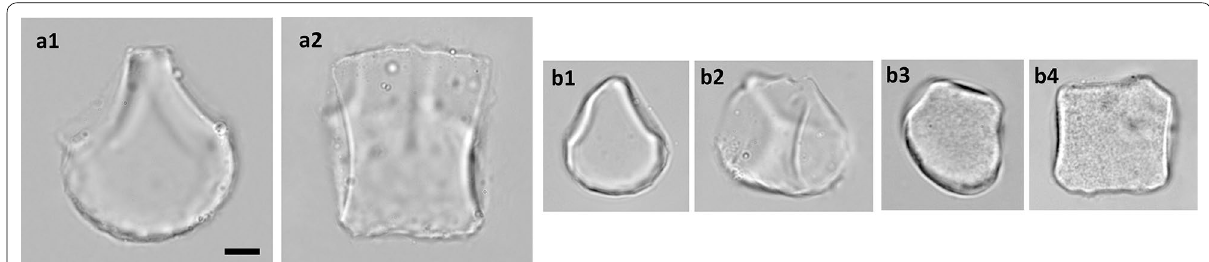
Fig. 5 Bulliform phytoliths of subfamily Oryzoideae. a O. sativa , b L. hexandra . 1 , 3 , end view; 2 , 4 , lateral view. Bar 10 μm, all pictures are in the same